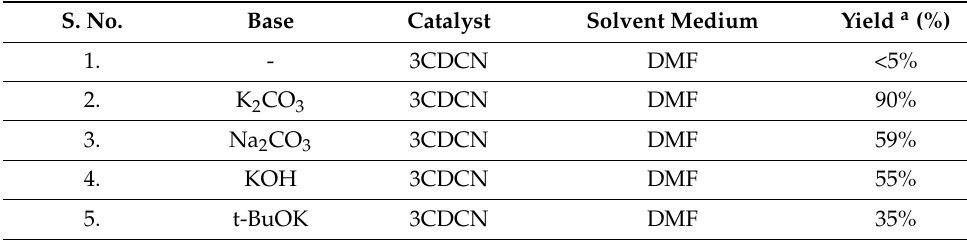
Table 2. Optimization of the base.